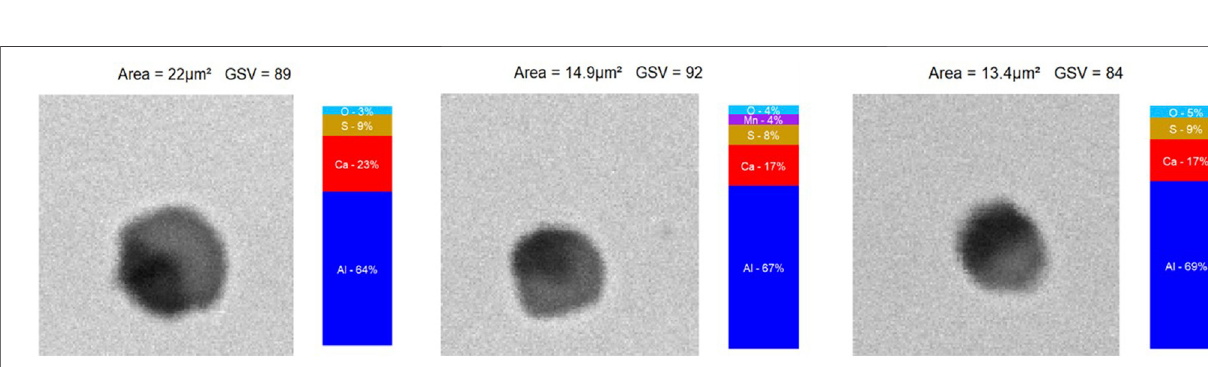
Frontiers in Materials |